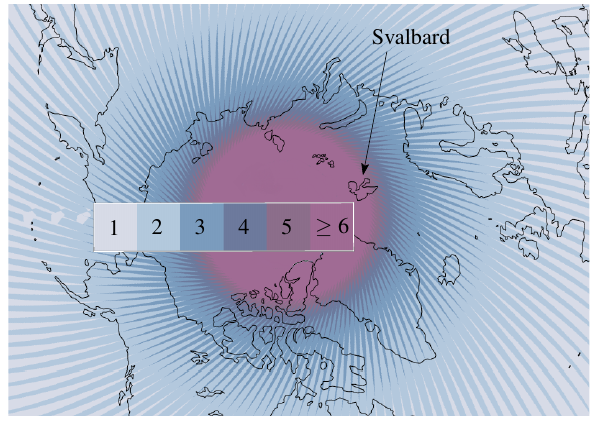
Figure 1. Illustration of the amount of times a point can be seen from the different orbits of